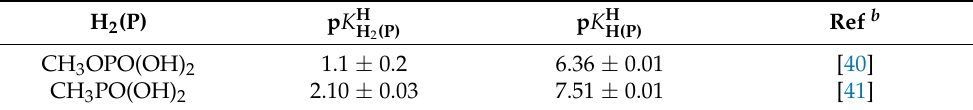
Table 1. Negative logarithm of the acidity constants (Equations (1) and (2)) for methyl phosphoric acid and methylphosphonic acid [H 2 (P)] in aqueous solution at 25 ◦ C and I = 0.1 M (NaNO 3 ) a